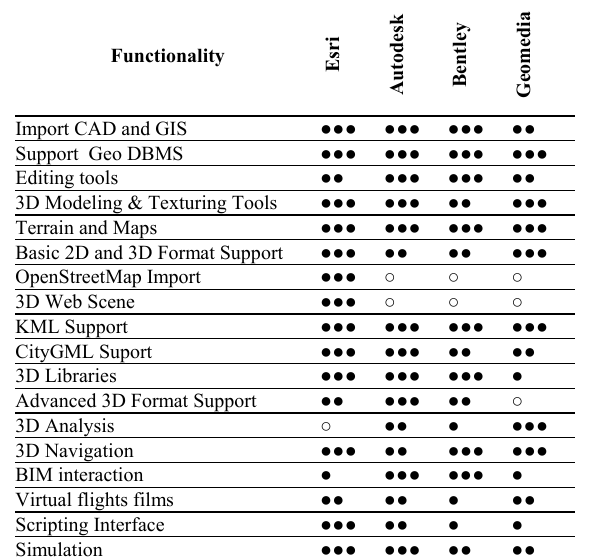
Figure 3. 3D model made with Esri CityEngine. Figure courtesy of Esri. As seen in the following table (Table 1) not all the software options are equal efficient for related functionalities.